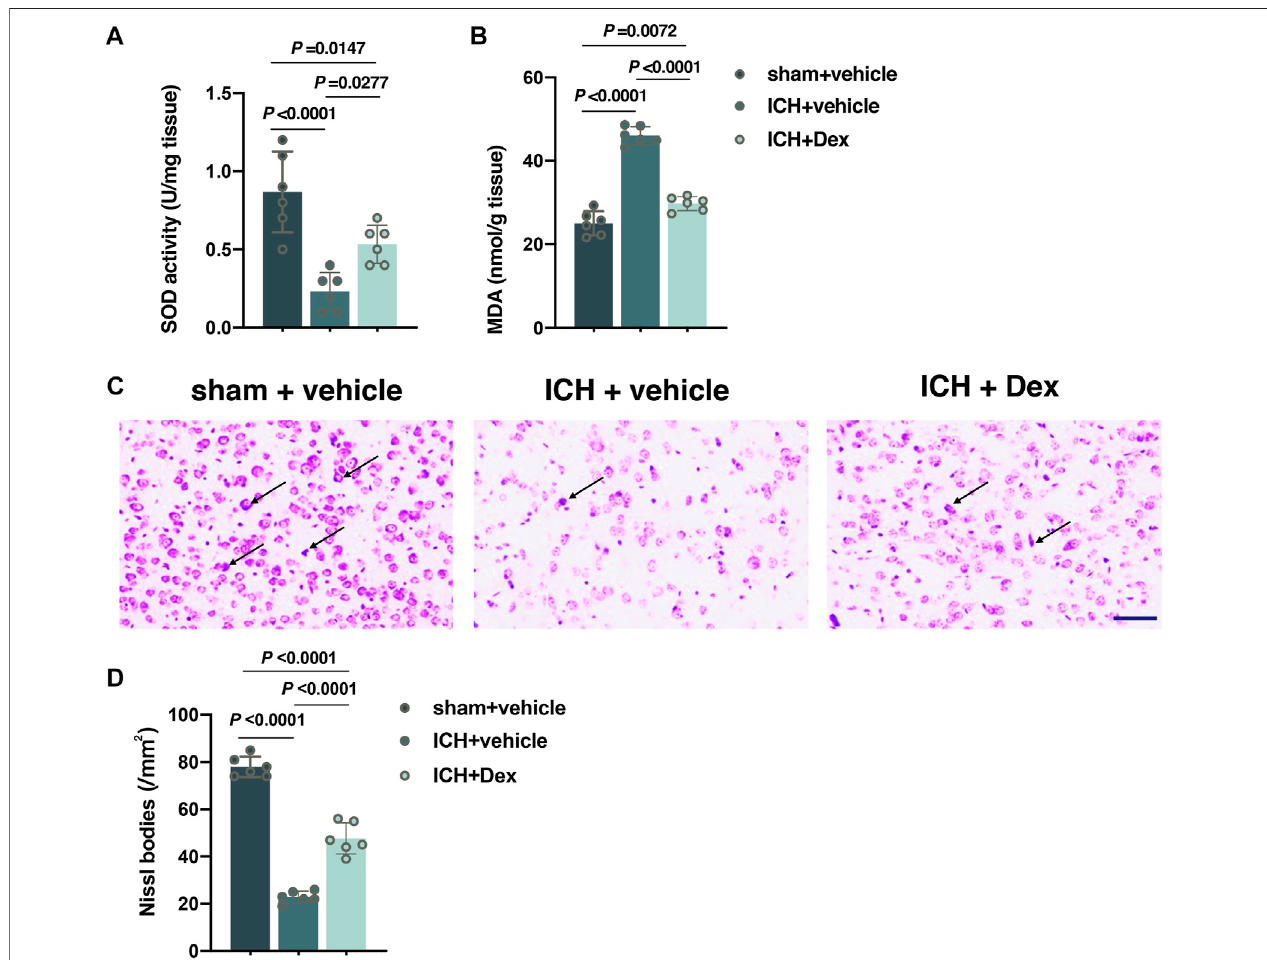
FIGURE 3 | Dexmedetomidine administration attenuated oxidative stress and neuronal injury after ICH exposure. (A,B) Changes in the total SOD and MDA contentsaroundthehematomainthecorpusstriatumcausedbytheindicatedstimuli. (C,D) RepresentativephotomicrographsofNisslstainingandNisslbodiesaround thehematomainthecorpusstriatumcausedbytheindicatedstimuli.ArrowsindicateNisslbodies.Dataarepresentedasthemean±SD( n =6).Sham,ICH,andDexare described above.